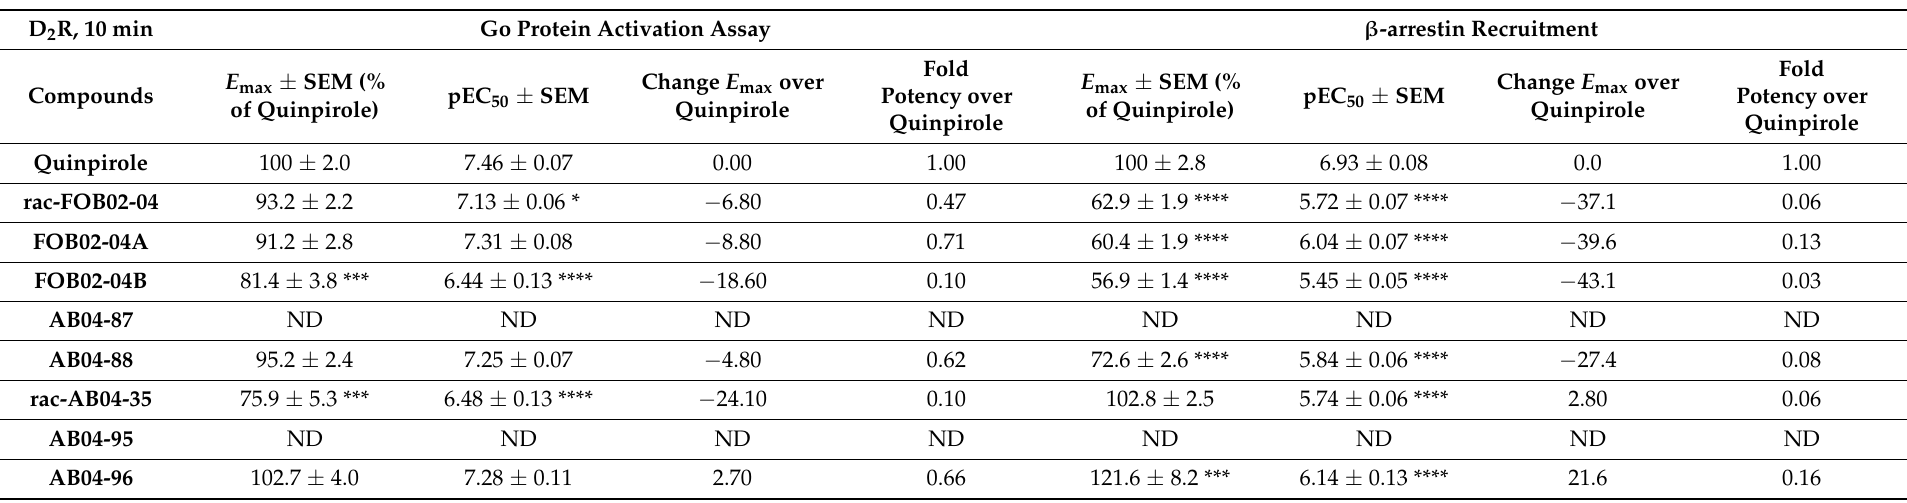
Table 2. Pharmacological comparison of bitopic ligands at